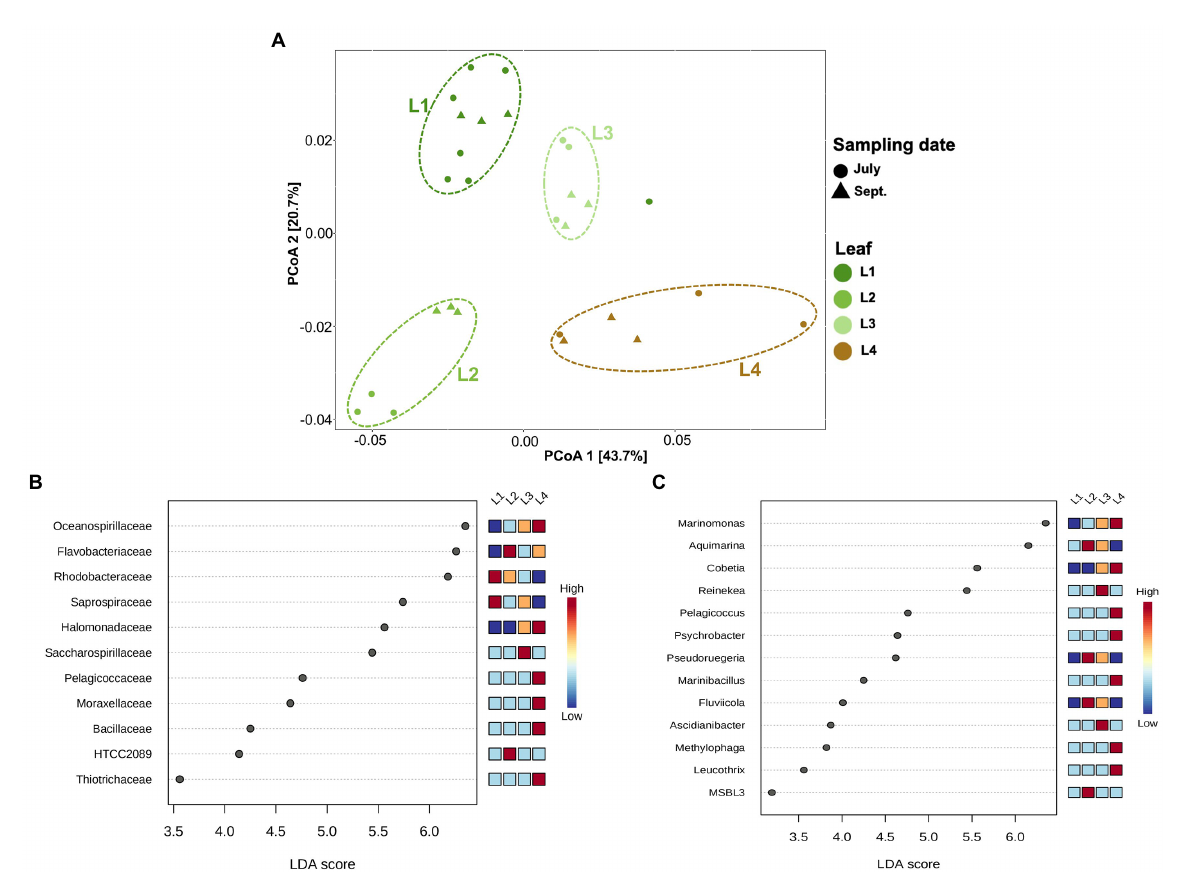
FIGURE 4 Principal coordinates analysis (PCoA) and LEfSe analysis among the phyllosphere (A) PCoA of microbial communities of the phyllosphere based on weighted UniFrac distance matrices. Samples are colored by leaf age (L1, L2, L3, etc.), with different shapes for the sampling date (July, September). (B) Linear discriminant analysis (LDA) effect size (LEfSe) analysis at the family level. (C) LEfSe analysis at the genus level. The differences were significant ( p < 0.05) among classes (Kruskal–Wallis test). The threshold of the logarithmic LDA score was >3.0. (L1–L3): differently aged leaves; L4: decayed